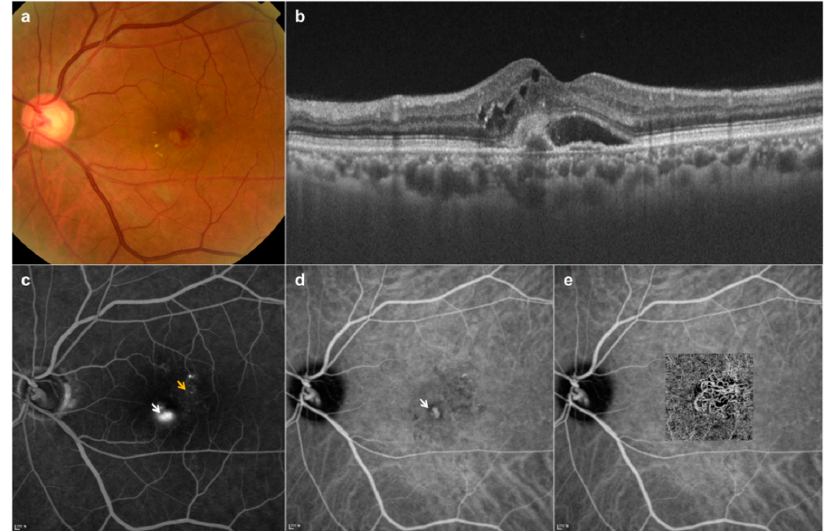
Figure 2. Multimodal images of neovascular age-related macular degeneration in a 61-year-old man. ( a ) Fundus photography shows subretinal fluid, exudation, and hemorrhage; ( b ) Optical coherence tomography (OCT) B-scan revealed non-uniform hyper-reflective formations above the retinal pigment epithelium and the presence of intraretinal cysts and subretinal fluid; ( c ) Fluorescein angiography (FA) demonstrates aspects of a well-defined (white arrow) and an irregular (yellow arrow) hyper-fluorescent lesion; ( d ) Indocyanine green angiography (ICGA) shows staining of the type 2 choroidal neovascularization (CNV) (white arrow); ( e ) An OCT angiography image (with the neovascular network) overlaid on the ICGA image.